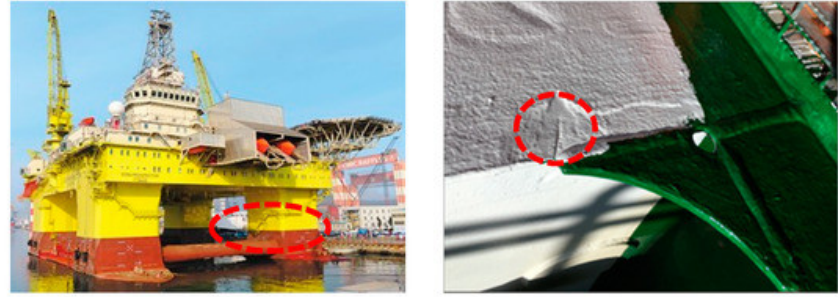
Figure 4. Crack at weld seam of offshore platform [9].